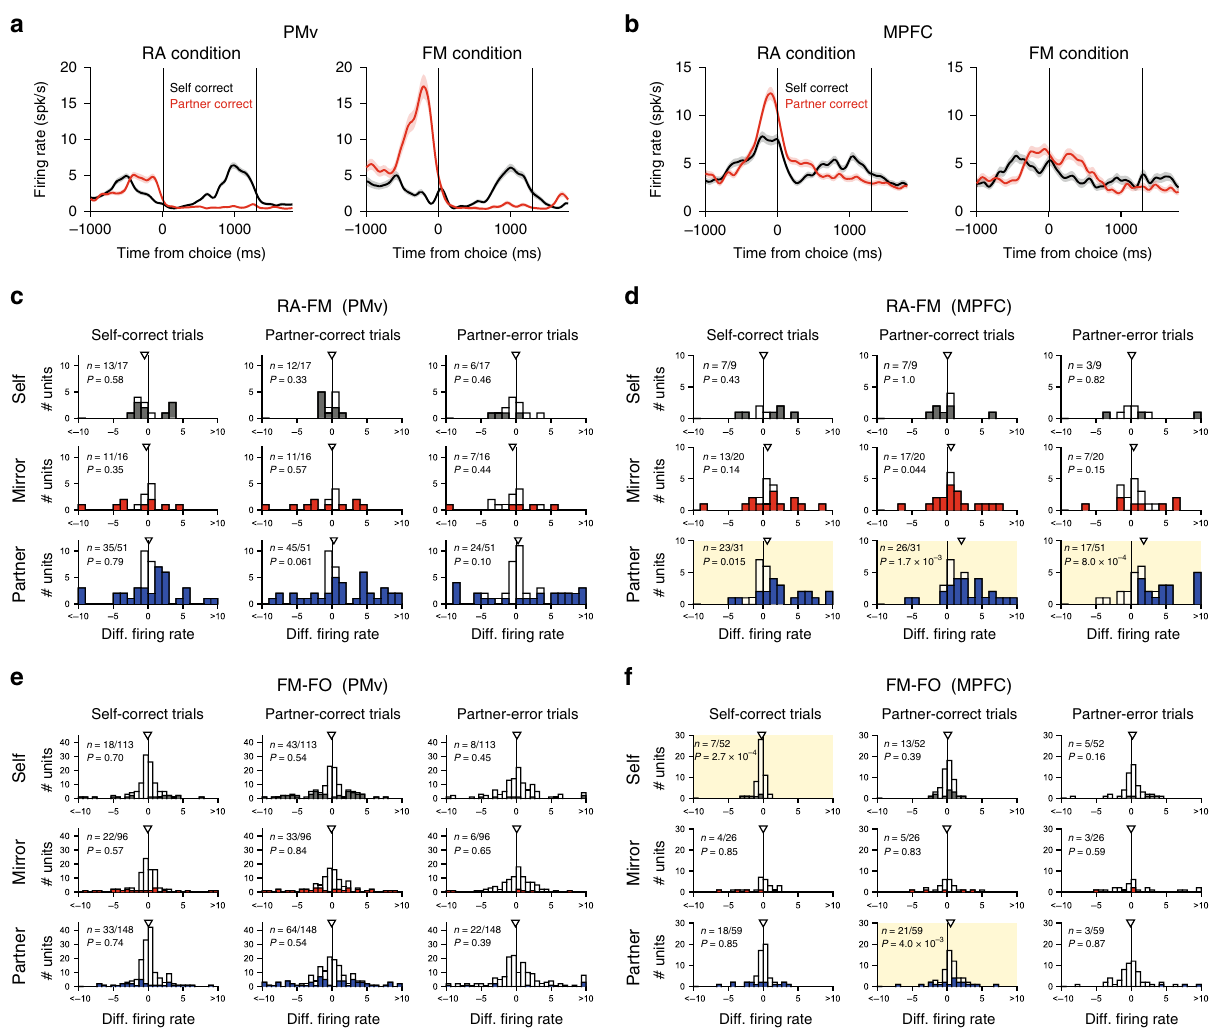
Fig. 3 Biological preference in PMv and MPFC. a Spike-density functions of a partner-type PMv neuron. Same conventions as in Fig. 2c. Shaded areas indicate s.e.m. b Spike-density functions of a partner-type MPFC neuron. c Histograms showing differential fi ring rates, de fi ned as [(activity in the RA condition) − (activity in the FM condition)], for PMv neurons. Self- (black), mirror- (red), and partner-type (blue) neurons (from top to bottom) in self- correct, partner-correct, and partner-error trials (from left to right). Triangles denote the medians. Filled bars indicate neurons with signi fi cant activity differences between the two conditions ( P < 0.01, permutation test, two-sided; see Methods). Fraction numbers in individual histograms denote the number of neurons with signi fi cant activity differences relative to the total number of neurons. P values, Wilcoxon signed-rank test (two-sided). d Differential fi ring rates between the RA and FM conditions for MPFC neurons. Yellow backgrounds indicate that median values (triangles) are signi fi cantly different from zero ( P < 0.05/3; Wilcoxon signed-rank test with Bonferroni correction, two-sided). Differential fi ring rates (FM – FO) for PMv neurons ( e ) and MPFC neurons ( f ). Same conventions as in ( c ) and ( d